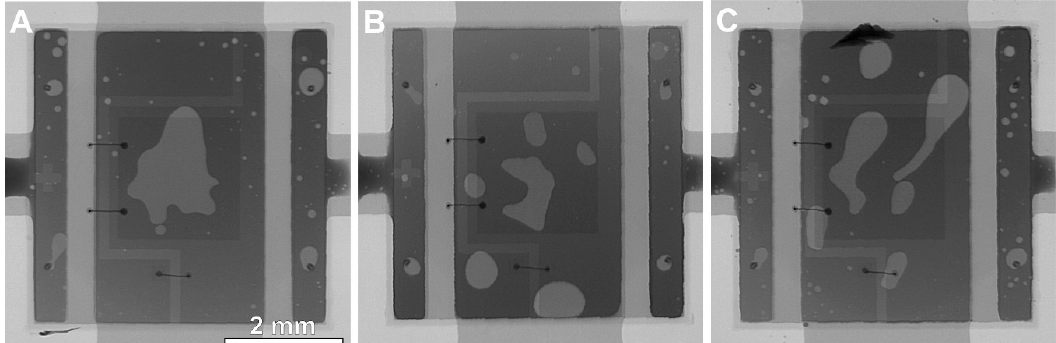
Figure 4. X-ray images of the solder joints under the LED component: ( A ) reference SACX0307 sample; ( B ) SACX0307-nanoTiO 2 sample; ( C ) SACX0307-TiO 2 sample.